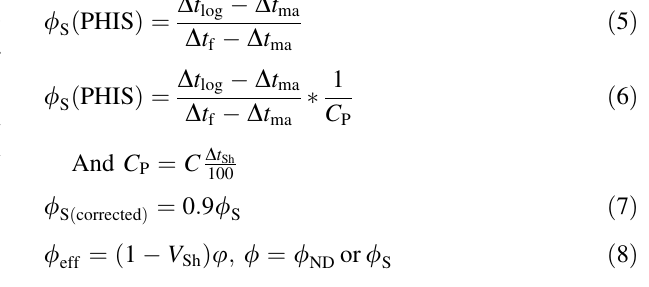
where D t ma , D t f and D t log are the matrix interval transit time (55.5 l s = ft ), apparent fluid interval transit time (189 l s = ft ) and the interval transit time from the sonic log, respectively. C is the shale compaction coefficient ranging from 1.0 to 1.3 depending on the regional geology. D t Sh is